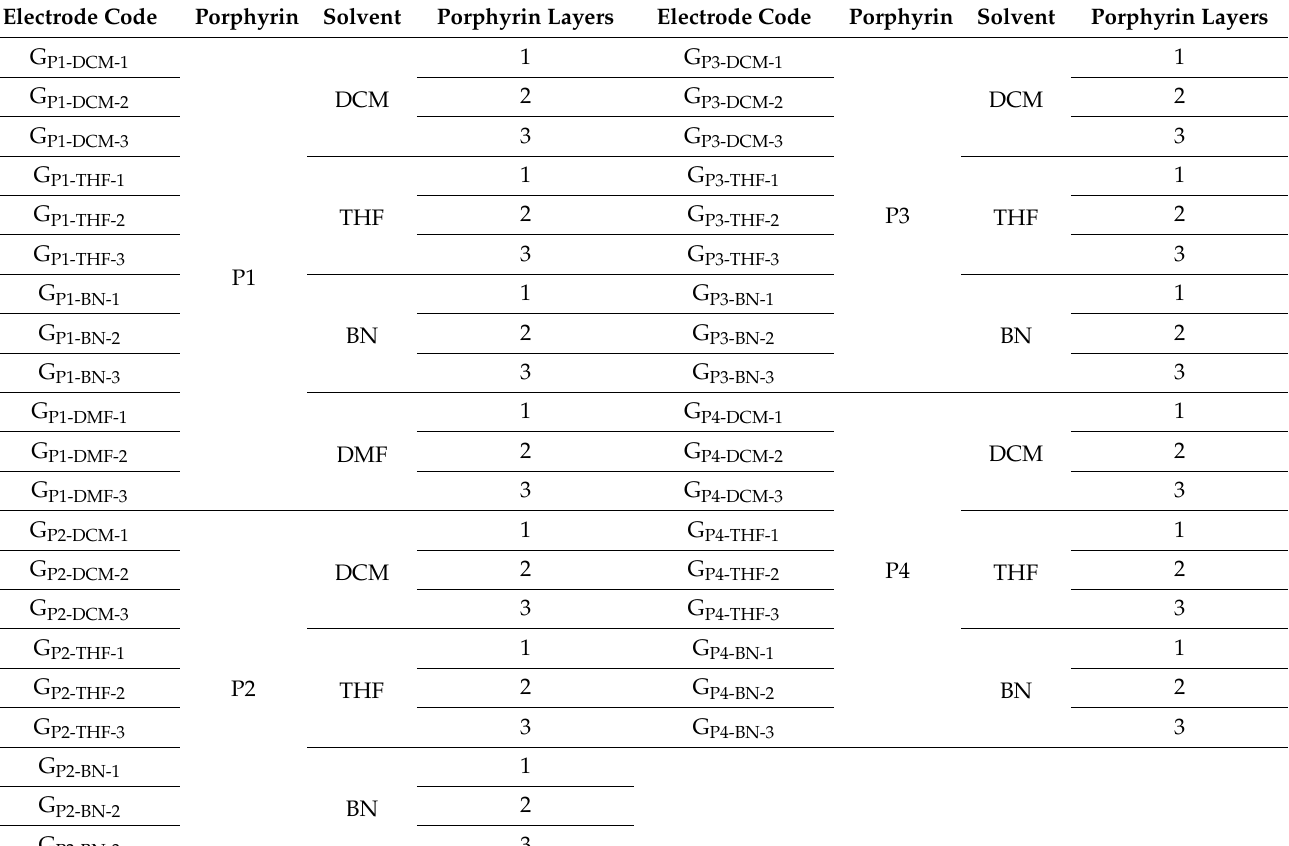
Table 1. The coding of the modified